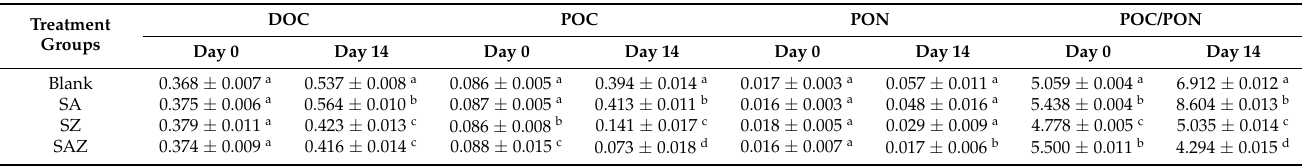
Table 2. Dissolved, particulate organic carbon, particulate organic nitrogen concentrations, and particulate organic carbon to nitrogen ratios for the four different cultures.